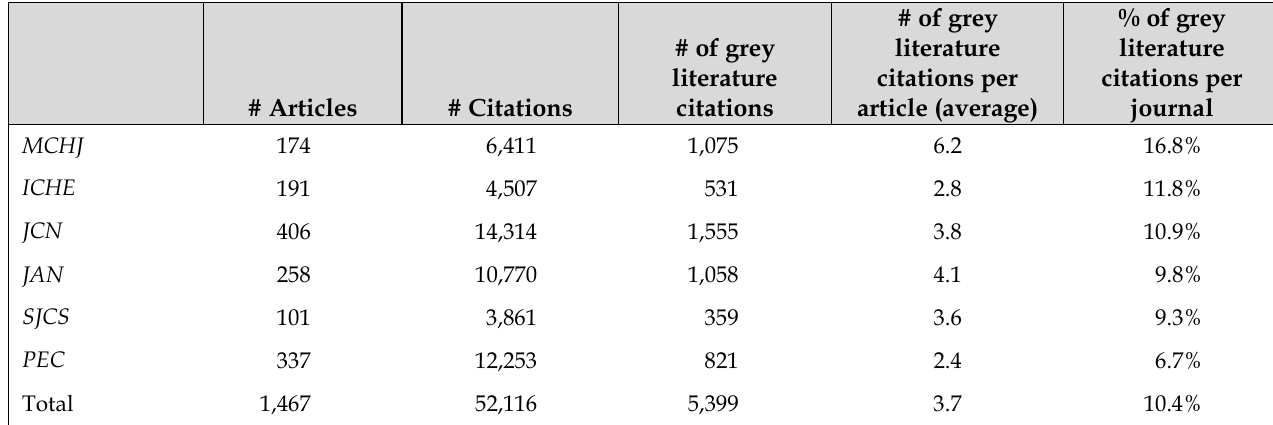
Table 2 Grey literature citations in nursing journals in 2011